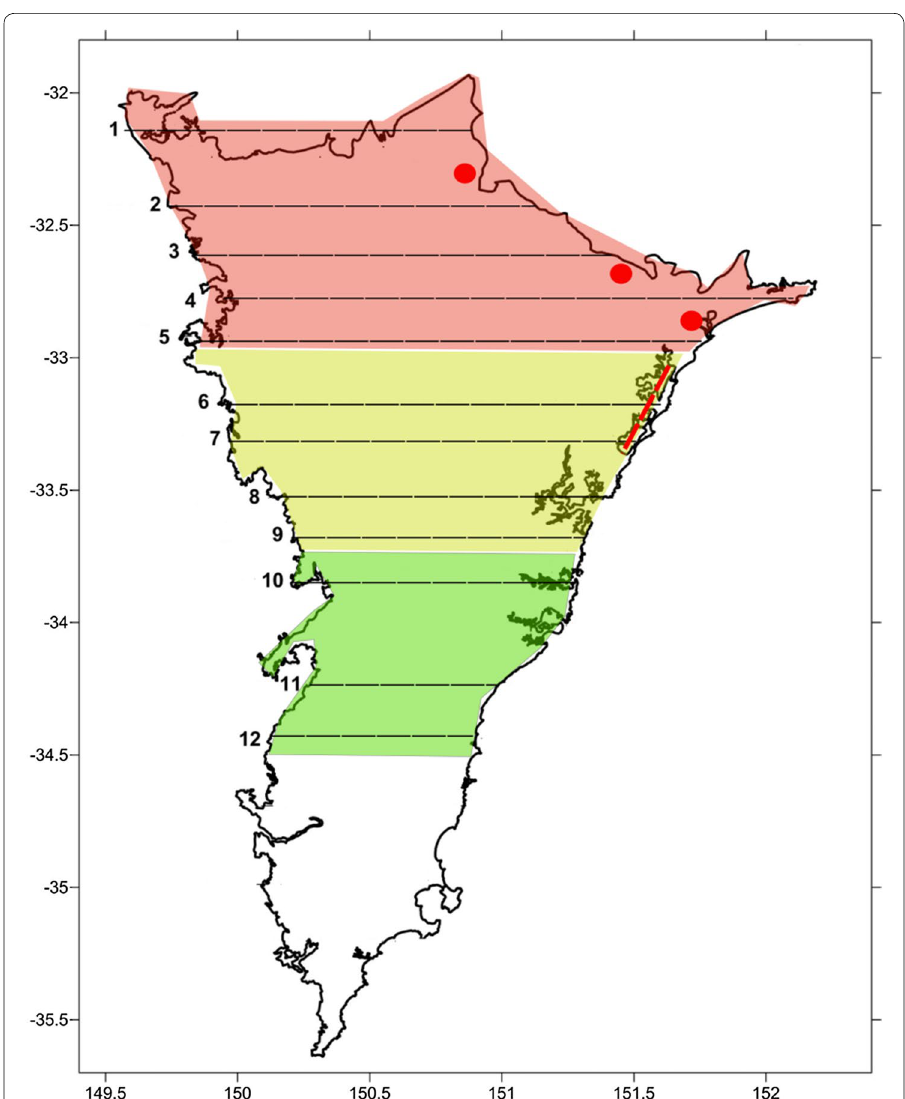
Fig. 5 Map of the Sydney Basin with profile orientation. Red region represents the Gulgong granites, yellow region represents the Bathurst granites and the Green region represents the Bathurst/Oberon/Wyangala granites. Red circles represent coal sample locations, and the red curved line represents area of sediment sample location (Norah head-Terrigal coastal outcrops) [Map adapted from Danis et al. (2012) and Evans (2013)